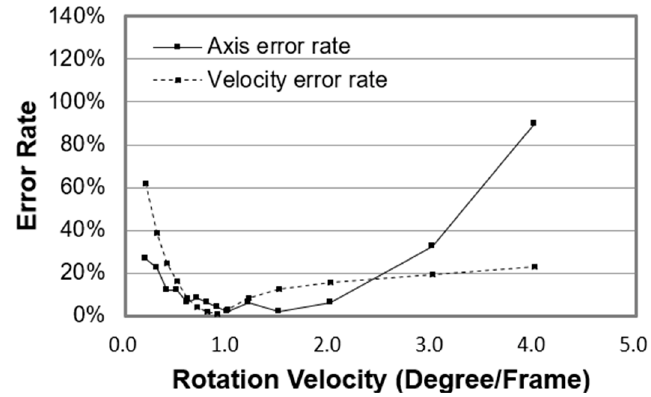
Figure 10. The error rates of the rotation axis and velocity.